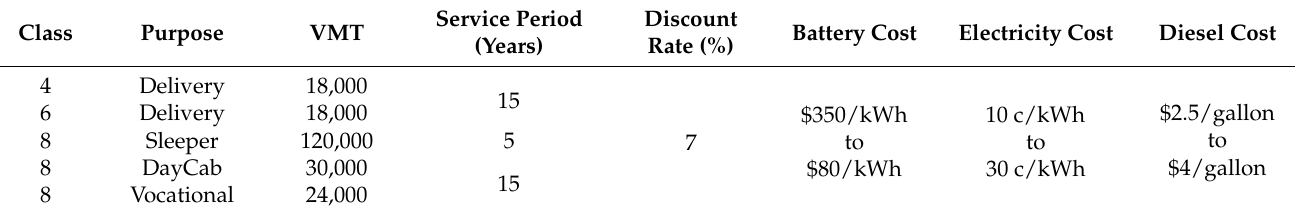
Table 6. Assumptions for TCO calculation.